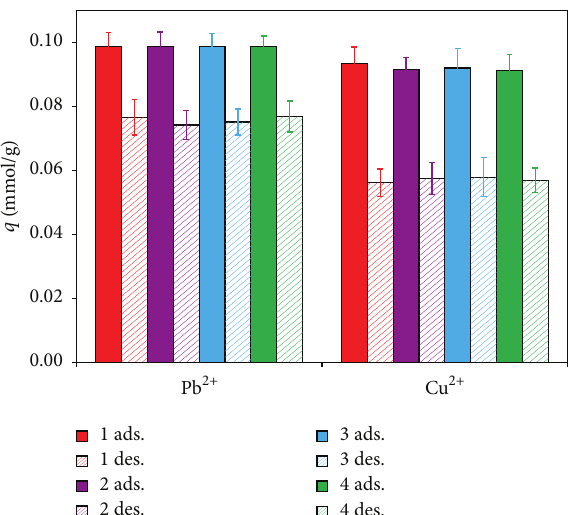
Figure 3: Adsorption-desorption cycles of Pb 2+ and Cu 2+ using calcium chloride. Experimental conditions: 0.1 mM initial metal concentration, pH 4.5, and 25 ∘ C. Error bars represent standard deviation of triplicate measurements.